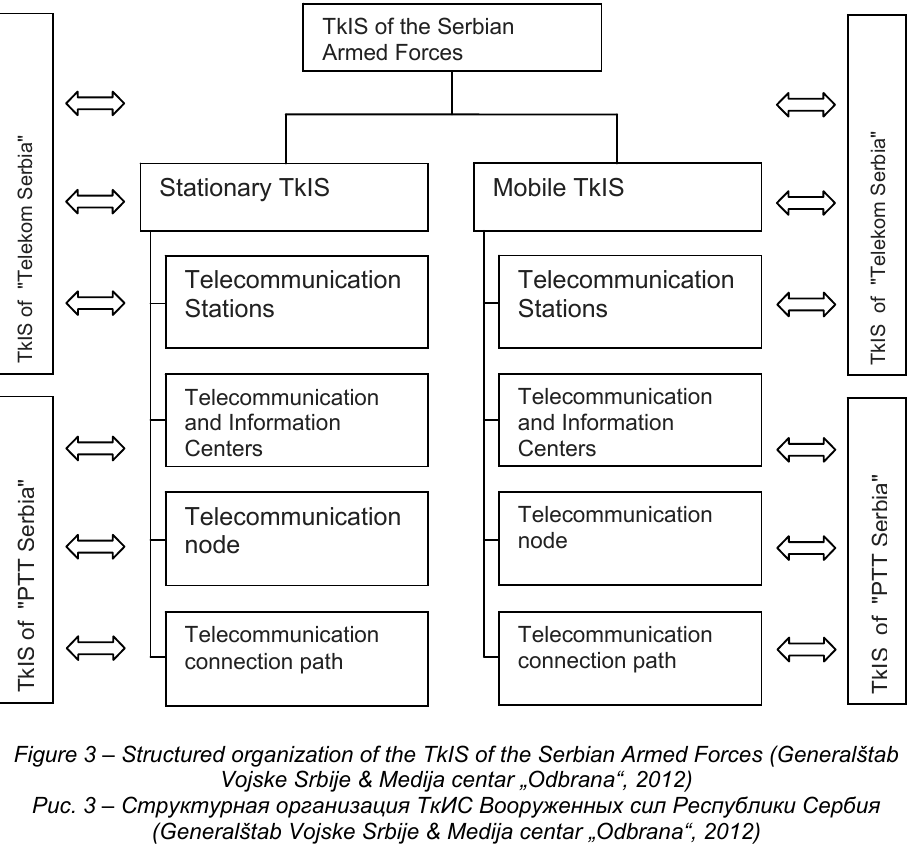
Figure 3 – Structured organization of the TkIS of the Serbian Armed Forces (Generalštab Vojske Srbije & Medija centar „Odbrana“, 2012) Рис . 3 – Структурная организация ТкИС Вооруженных сил Республики Сербия (Generalštab Vojske Srbije & Medija centar „Odbrana“, 2012) Слика 3 – Структурна организација ТкИС Војске Србије (Generalštab Vojske Srbije & Medija centar „Odbrana“,